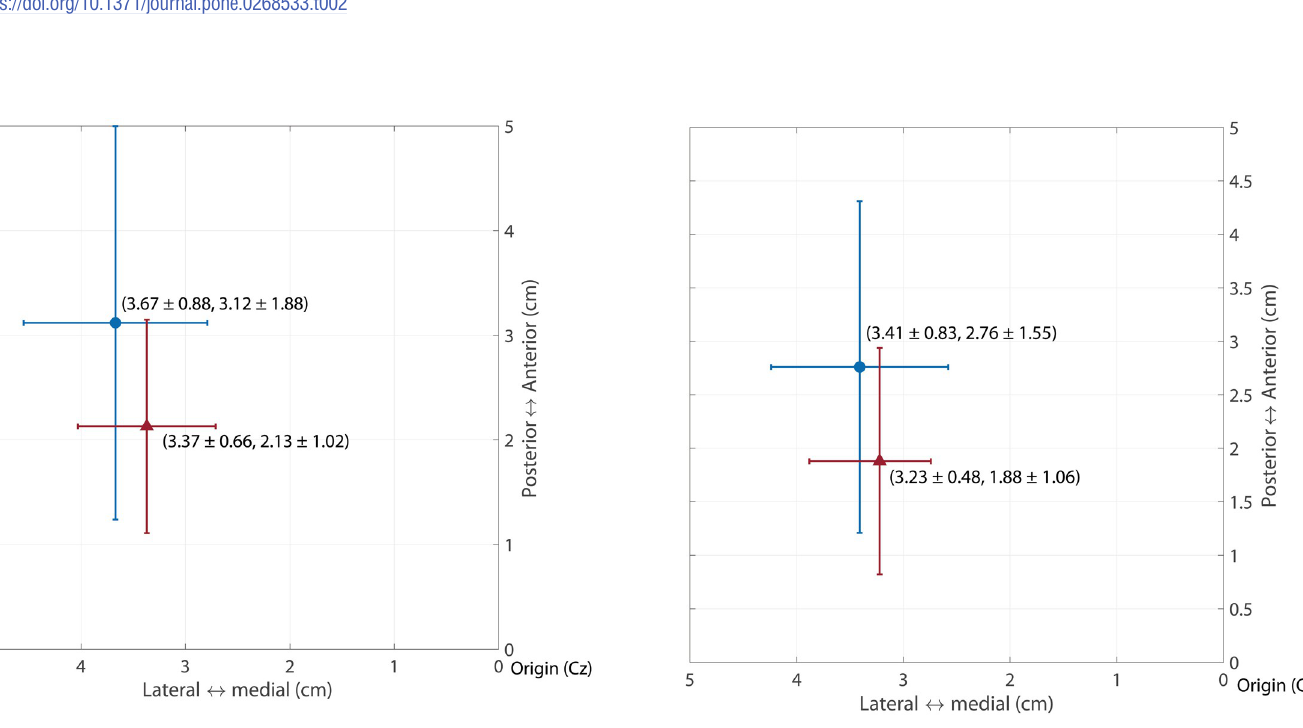
Fig 3. The COG in the SIS and comparison groups. Red triangle: SIS group; blue circle: Comparison group. (A) upper trapezius; (B) serratus